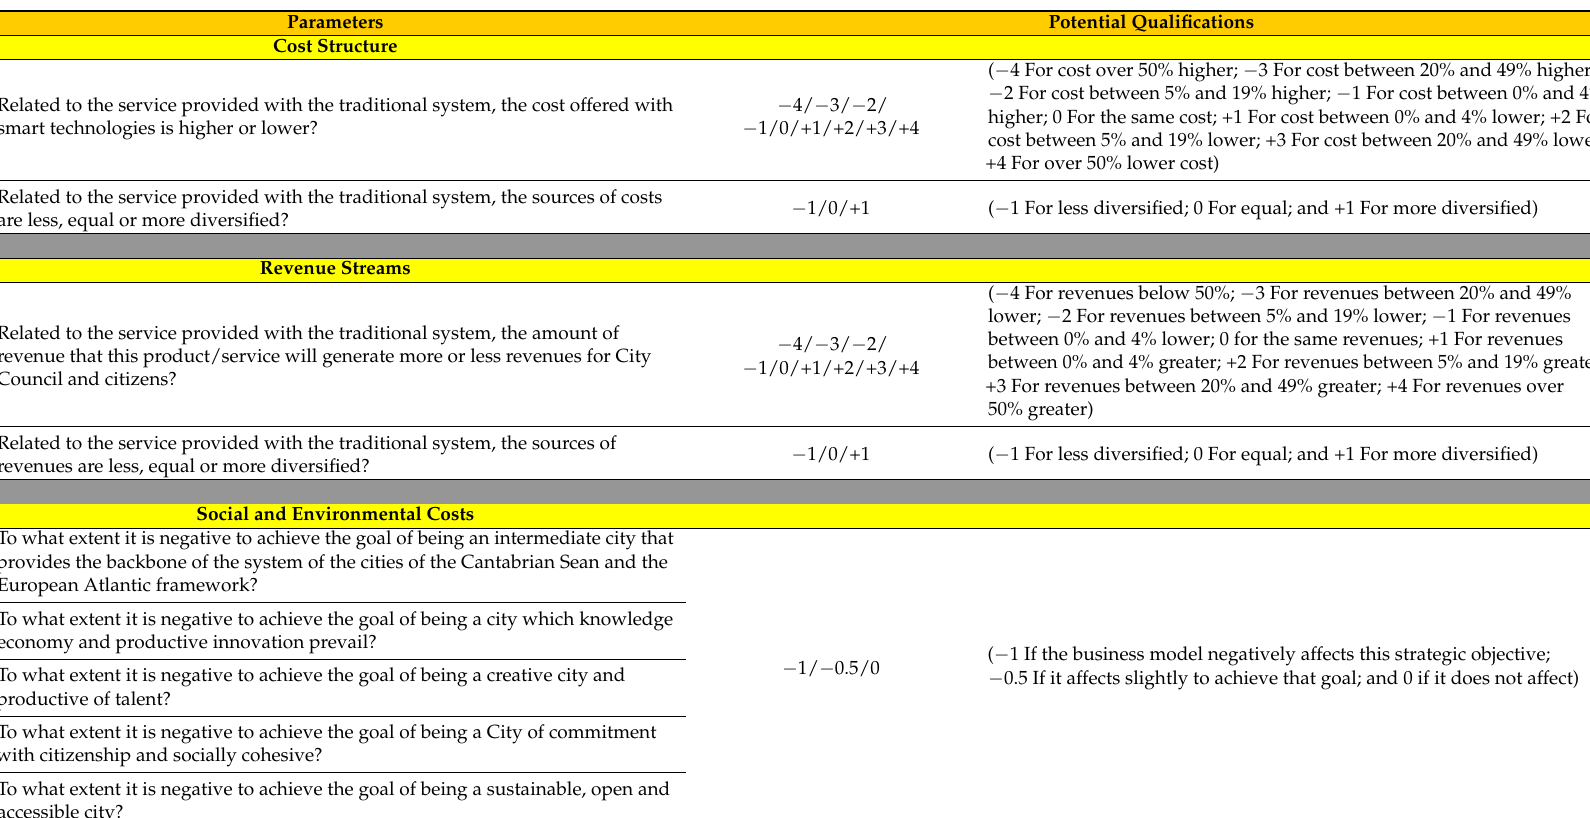
Table 2. The Evaluation Tool for Business Model Analysis in Smart